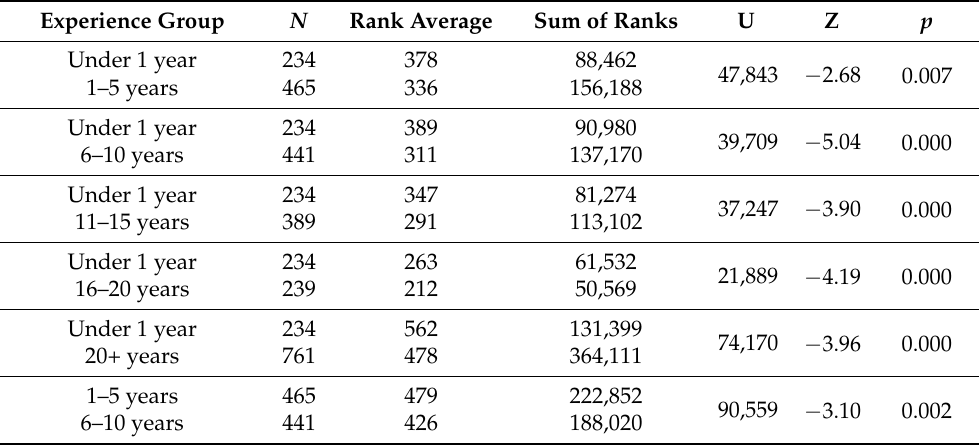
Table A9. Mann-Whitney test results for mining experience groups and